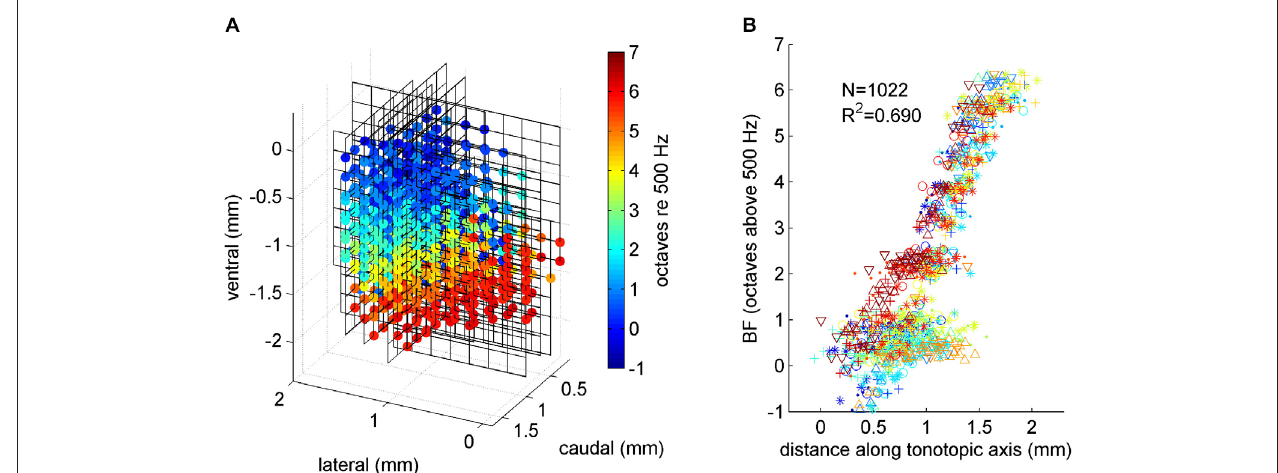
subjected to linear regression analysis to determine the best fit tonotopic axis of the gerbil ICc. (B) Multiunit BF plotted against location along the tonotopic axis. Data from each of the six animals in our study were plotted using a different symbol and color. A random Gaussian distributed jitter with a standard deviation of 0.09 octaves has been added to the BF values to spread out overlapping data